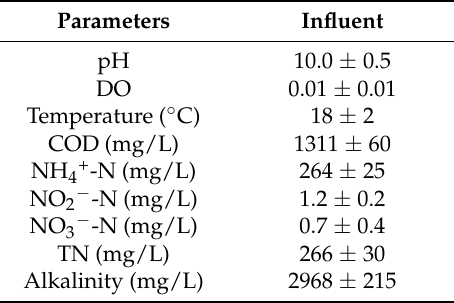
Table 1. Influent compositions of the three horizontal sub ‐ surface flow constructed wetlands.